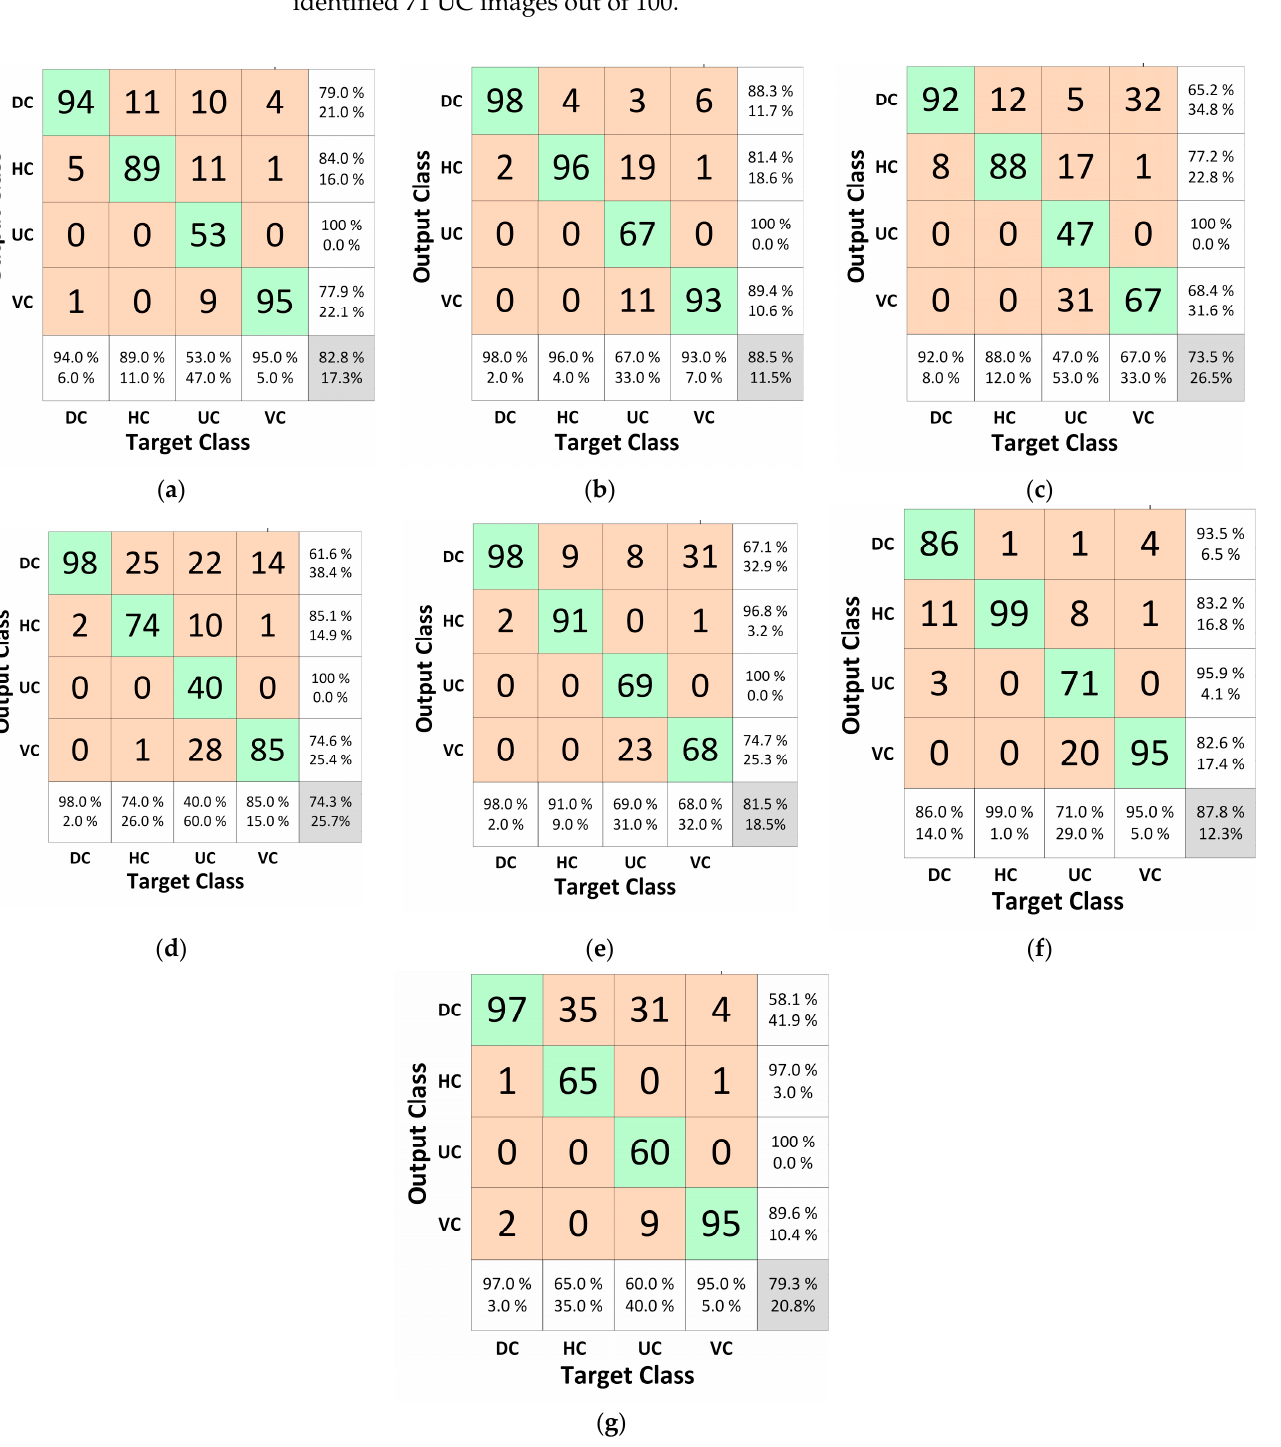
Figure 4. Confusion matrix plots for selected architecture: ( a ) GooLeNet, ( b ) Inception-V3, ( c ) MobileNet-V2 ( d ) ResNet18, ( e ) ResNet50, ( f ) ResNet101, ( g ) ShuffleNet.